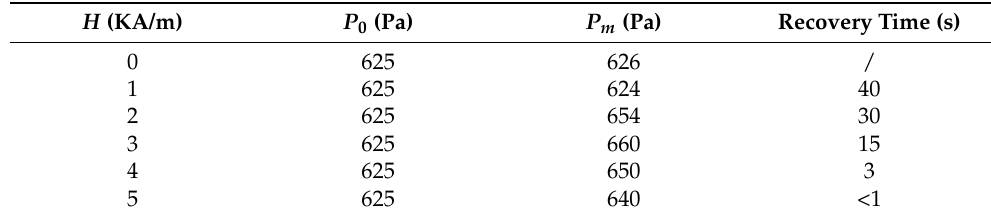
Figure 6. ‘Sudden change of pressure drop’ in the bed of ‘adding magnetic field later’.